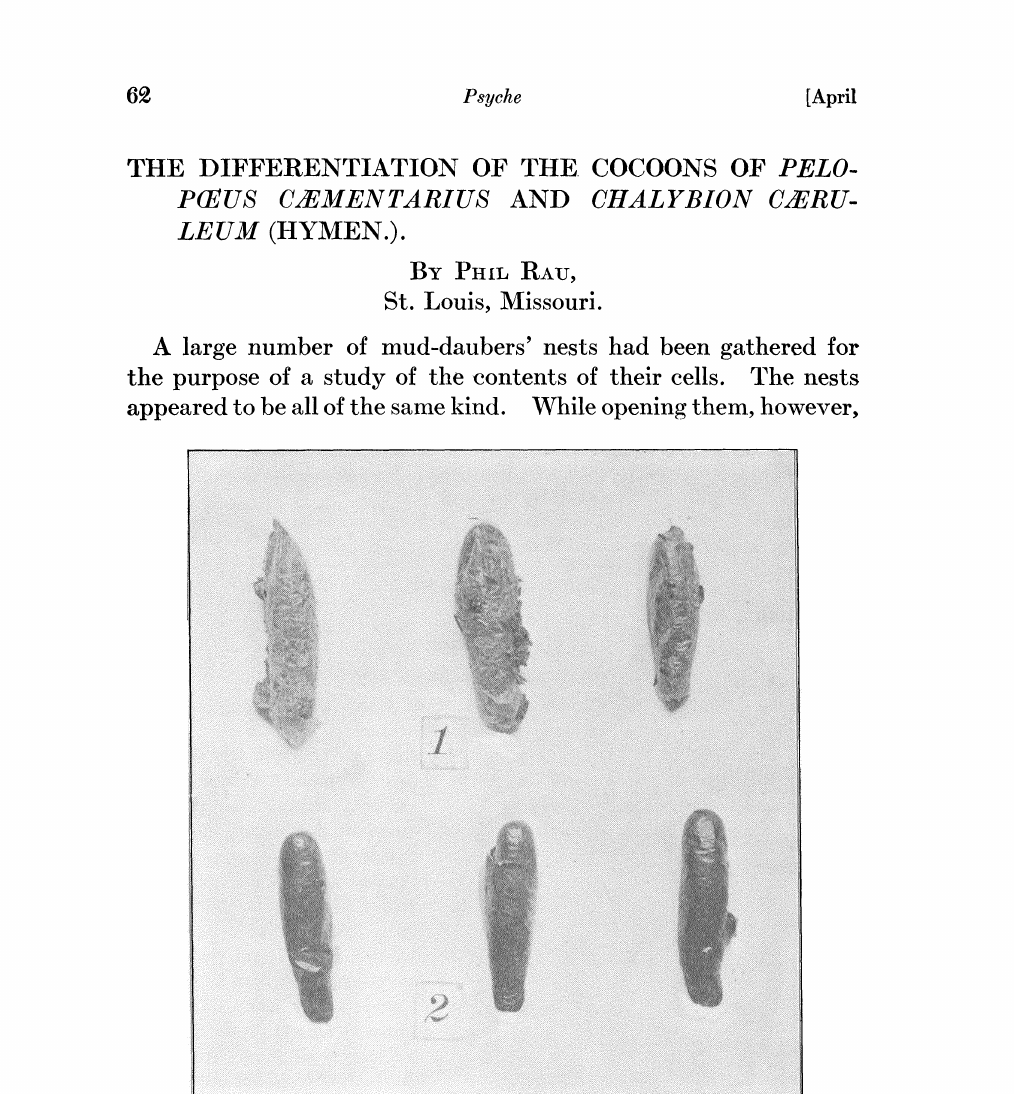
, Cocoons of Pelopus ceementarius.